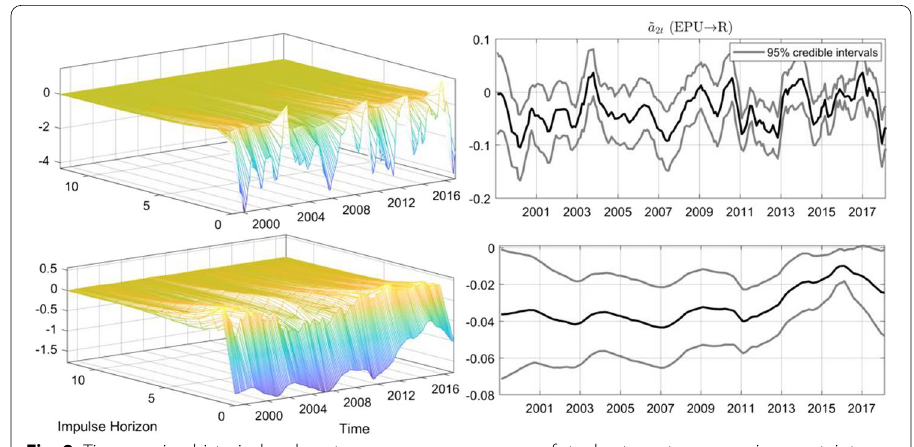
Fig. 8 Time-varying historical and contemporaneous responses of stock returns to economic uncertainty shocks. Right panel: historical impulse responses. Left panel: Contemporaneous response. Top: Results from TVP-VAR-SV under the order { EPU , NEF , R } . Bottom: Results from the TVP-VAR-SV under the order { EPU , R , NEF